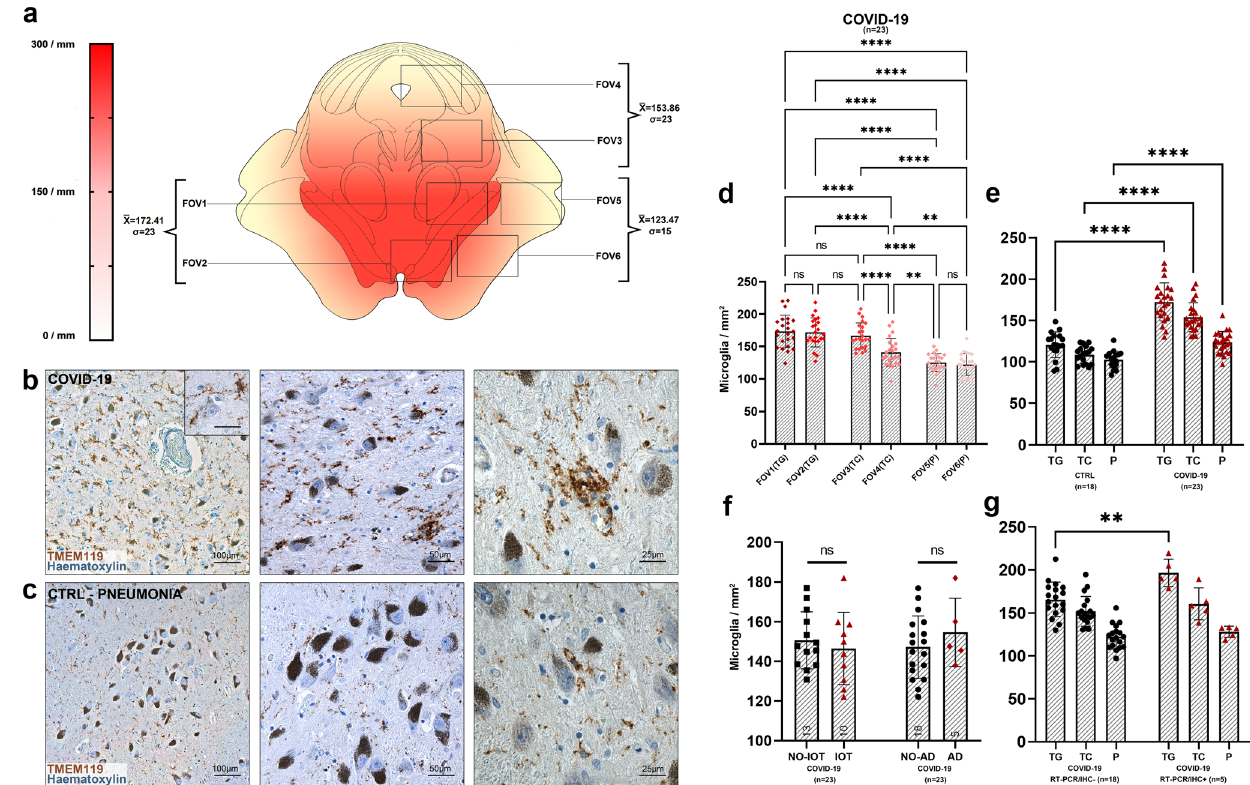
Fig. 10 Anatomically segregated microgliosis of the ventral midbrain was signi fi cantly higher in COVID-19 when compared to pneumonia patients. a Anatomical heatmap of activated microglia within the medulla oblongata in COVID-19. b , c TMEM119 immunoperoxidase staining of comparable regions of the midbrain in COVID-19 subjects (above) and controls (below). Inset: perineuronal microglia in the substantia nigra. COVID-19 subjects often present distinct microglial nodules. d Welch one-way ANOVA of microglial densities per counting fi elds (FOV) reveals statistically signi fi cant differences between FOVs of the Tegmentum (T; FOV1 – 2) when compared to FOVs of the Pes (P; FOV5 – 6), suggesting for a localized pattern of microgliosis comprising the preacqueductal tegmentum and the substantia nigra. e Welch one-way ANOVA between anatomical compartments (TG, tegmentum; TC, tectum; P, pes) between COVID-19 subjects ( n = 23, red) and controls ( n = 18, black) reveals statistically signi fi cant differences between all anatomical districts of the midbrain ( p < 0.0001). f Welch corrected t -test plot of microglial densities (microglia/mm 2 ) in the midbrain of COVID-19 subjects with ( n = 5, red) and without ( n = 16, black) Alzheimer ’ s disease neuropathological changes ( p > 0.05), and of COVID-19 subjects treated ( n = 10, red) and not treated ( n = 11, black) with intensive oxygen therapy ( p > 0.05). g Welch one-way ANOVA between anatomical compartments (TG tegmentum, TC tectum, P pes) between COVID-19 subjects with ( n = 5, red) and without ( n = 18) viral tropism (RT-PCR/IHC + versus RT-PCR/IHC − ) reveals statistically signi fi cant differences at the level of the midbrain tegmentum ( p = 0.0074), but not other anatomical districts. Error bars indicate standard